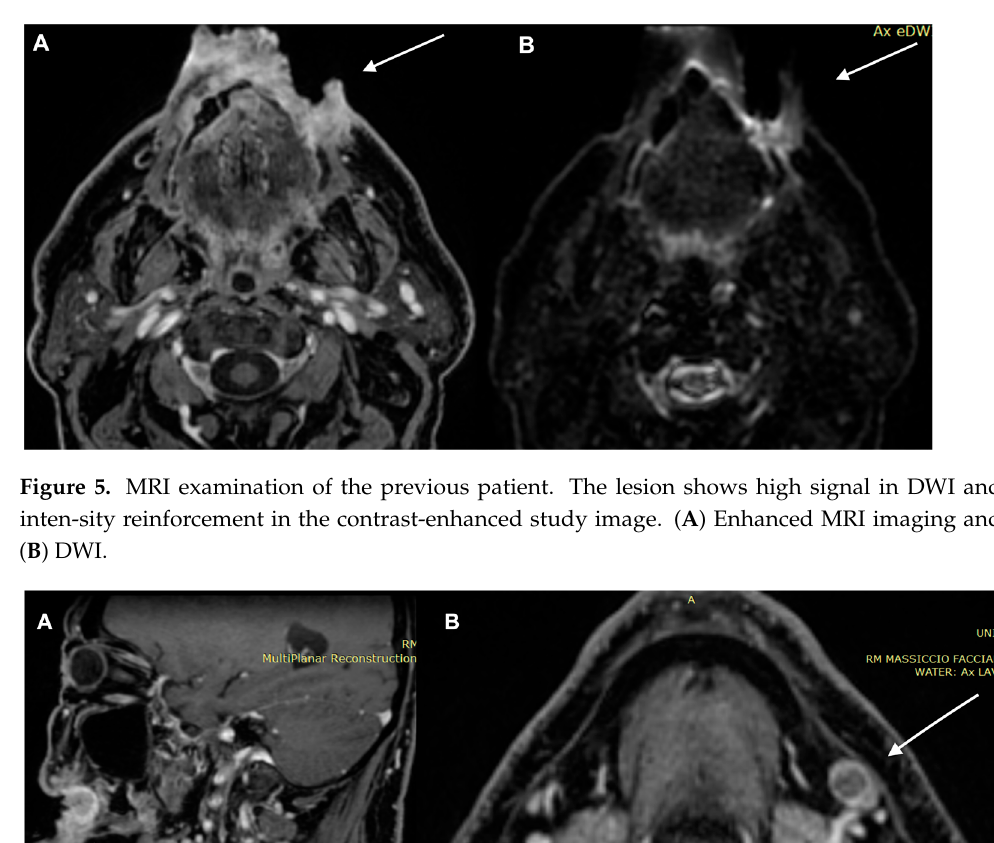
Figure 4. A 65-year-old male patient MRI examination. Lesion interesting the cutaneous and subcu- taneous tissues without involving the bone tissue. ( A ) T1 weighted imaging and ( B ) T2 weighted imaging.